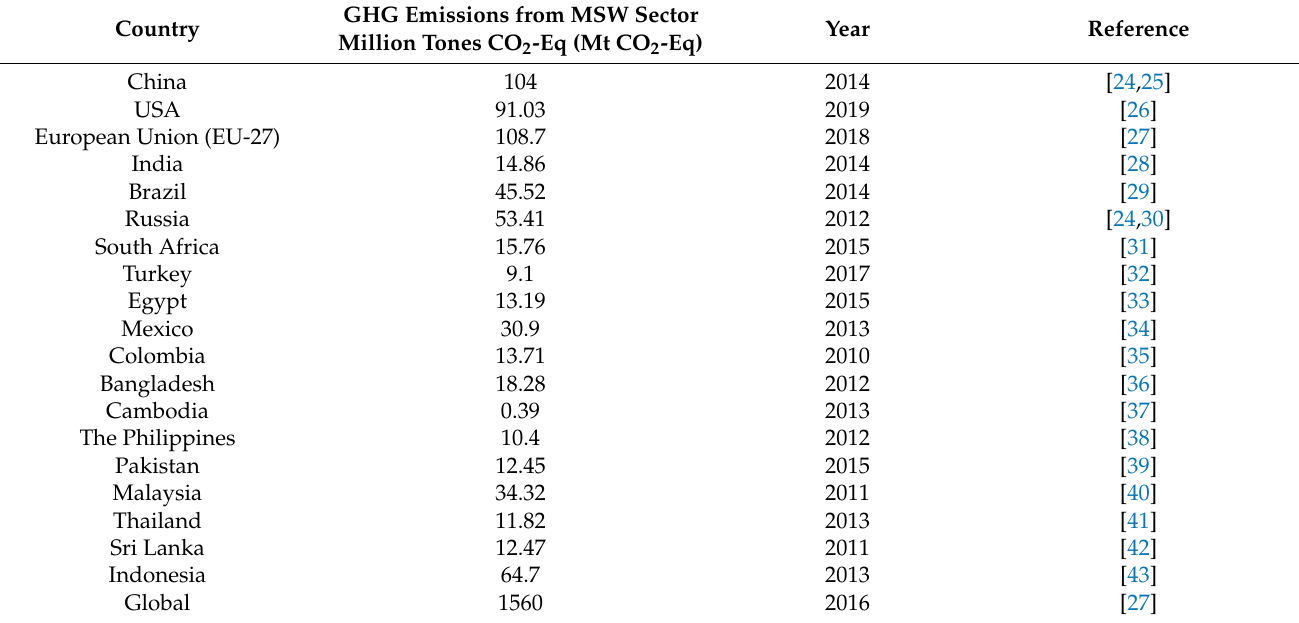
Table 1. Greenhouse gas (GHG) emissions from the municipal solid waste (MSW) sector in developing countries. Country